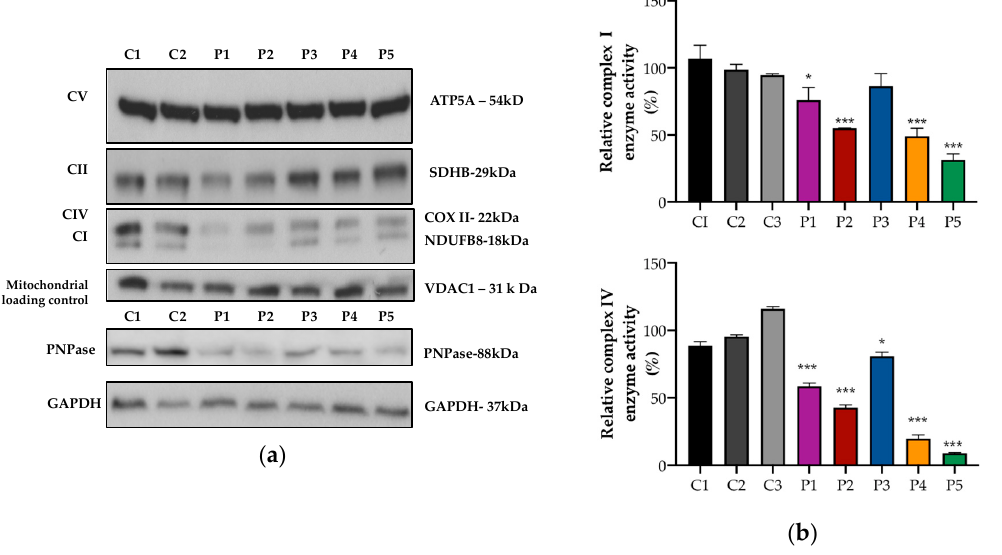
Figure 4. Protein expression and OXPHOS activity in fibroblasts. ( a ) Representative images of Western blot analysis performed in fibroblast proteins from controls (C) and patients (P). In the patients, there was a reduction in protein expression of PNPase (lower panel) and complex I and complex IV OXPHOS mitochondrial subunits (upper panel). ( b ) Complex I (upper panel) and complex IV (lower panel) enzyme activity was analyzed using dipstick activity assays. In the patients, there was a mild / moderate reduction in complex I and complex IV enzyme activities. The mean and variation (SEM) between three independent experiments are shown. (*** p < 0.001, * p <